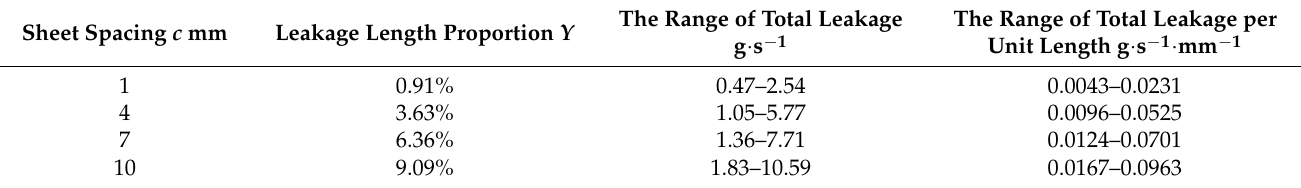
( b ) Figure 11. The experimental results curves of clearance leakage and equivalent mass flow of clear- ance leakage under different sealing sheet spacing. ( a = 1.0 mm). ( a ) Clearance leakage against pres- sure ratio. ( b ) Equivalent leakage against pressure ratio.